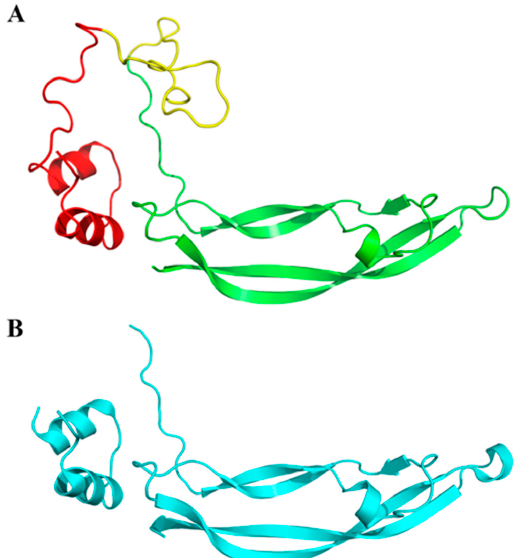
Figure 2. Goat PDGF subunit A3D protein structure. ( A ) The yellow structure is the signal peptide, red alpha-helix constitutes the propetide that is removed when the protein becomes mature; the green structures show the functional part, which are the beta sheets; ( B ) The human PDGF subunit Acrystallographic structure is reported for